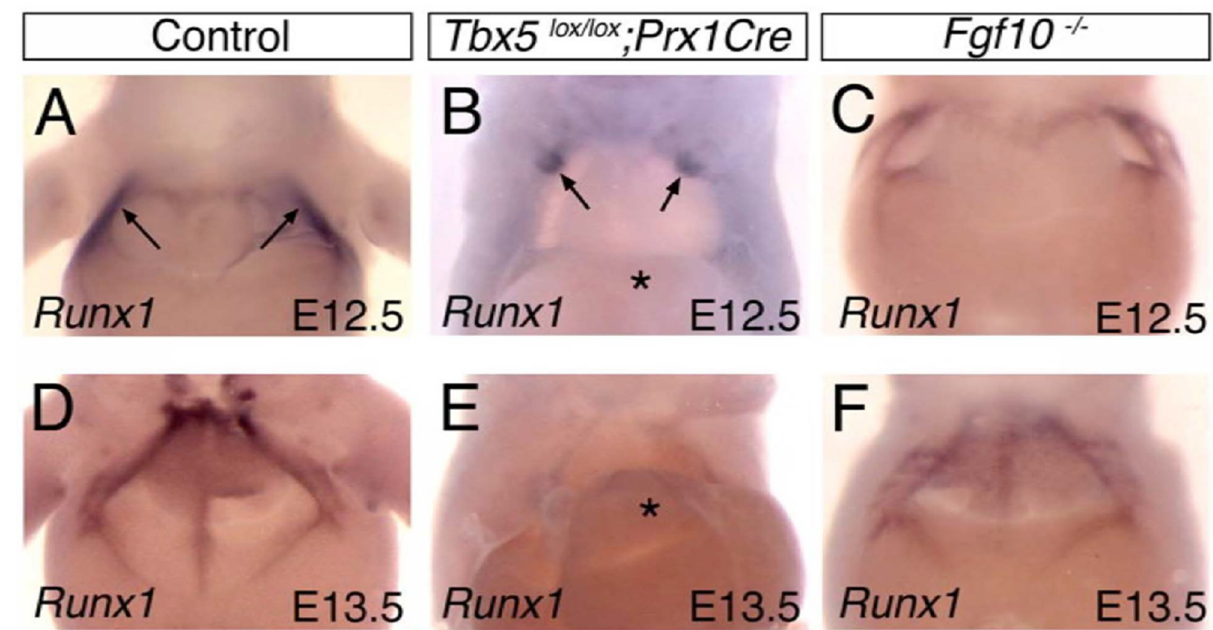
Figure 1. In situ hybridisation for Runx1 in control, Tbx5 lox/lox ;Prx1Cre and Fgf10 -/- mice. Ventral views of embryos at E12.5 ( A – C ) and E13.5 ( D – F ). Runx1 is expressed in the sternal bands (arrows) in control ( A , D ) and Fgf10 -/- ( C , F ) embryos, but is restricted to a region of the ventral body wall in E12.5 Tbx5 lox/lox ; Prx1Cre mice (arrows, B ) and is not detected in E13.5 Tbx5 lox/lox ; Prx1Cre mice ( E ). Herniation of the internal organs following the failure of body wall closure is present in B and E (asterisk). Figure adapted from [8].